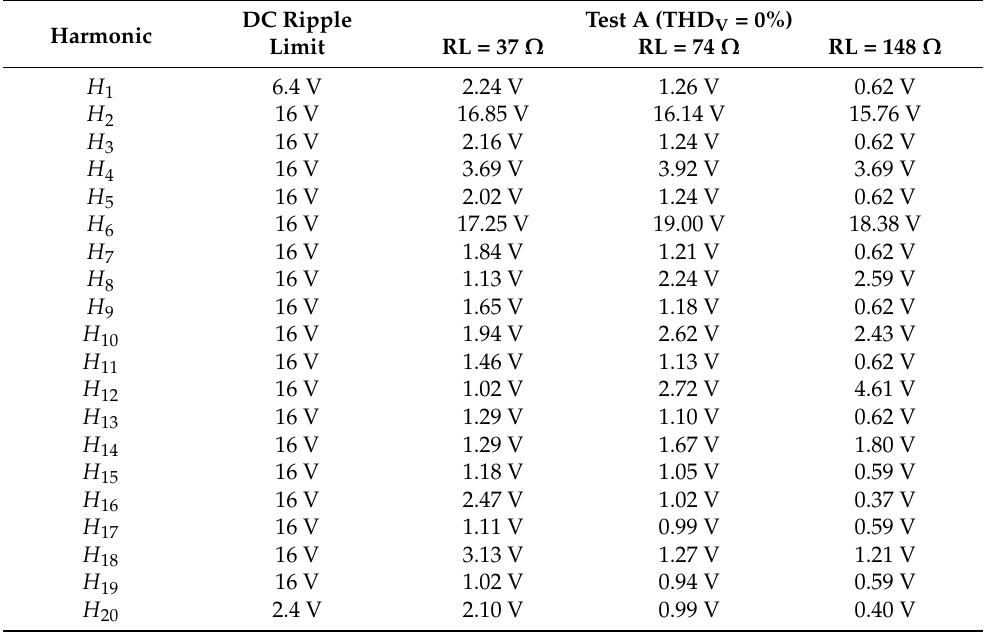
Table 14. Ripple voltage for ATU total harmonic distortion.